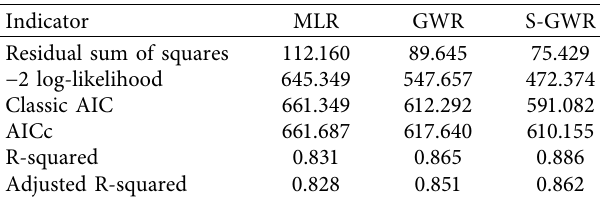
Figure 11: Spatial distribution of the R-squared of the S-GWR model. Table 7: Comparison of model